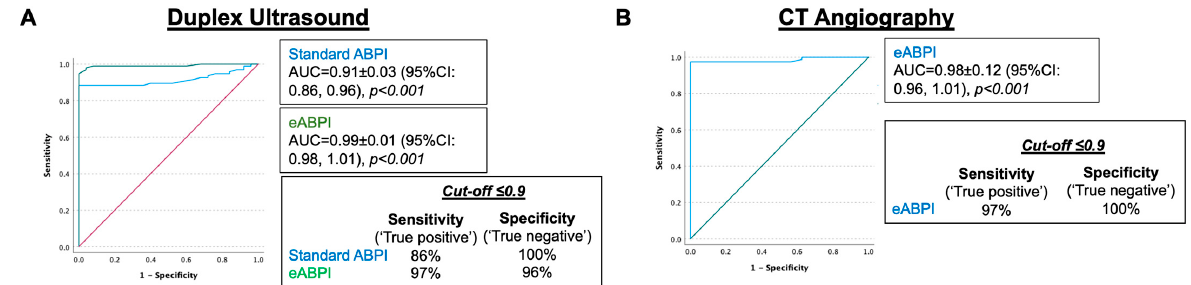
Figure 5. ROC analysis to test the diagnostic performance of eABPI ( A , B ) and standard ABPI ( A ) to detect PAD as ( A ) diagnosed with Duplex ultrasound ( n = 117) and ( B ) computed tomography (CT) angiography ( n = 111) as imaging standards.